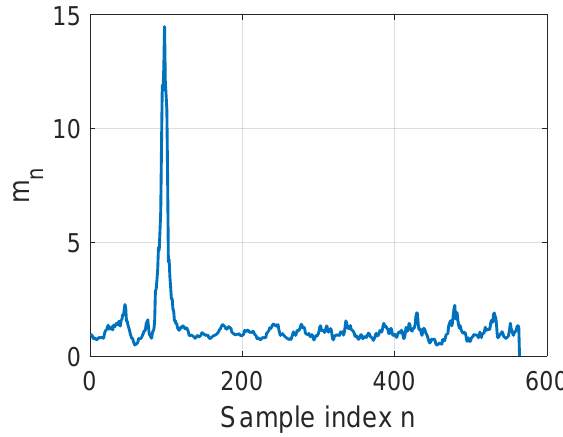
Figure 8. The response of double sliding window packet detection